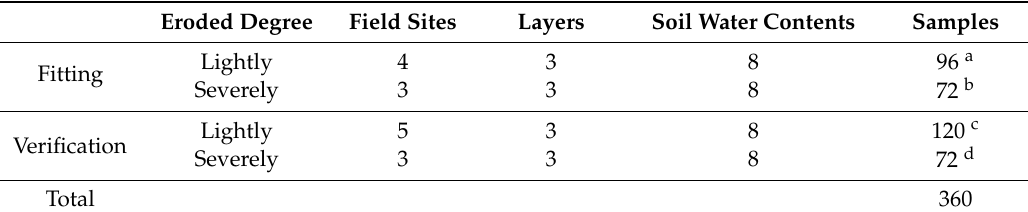
Table 2. The number samples used in this